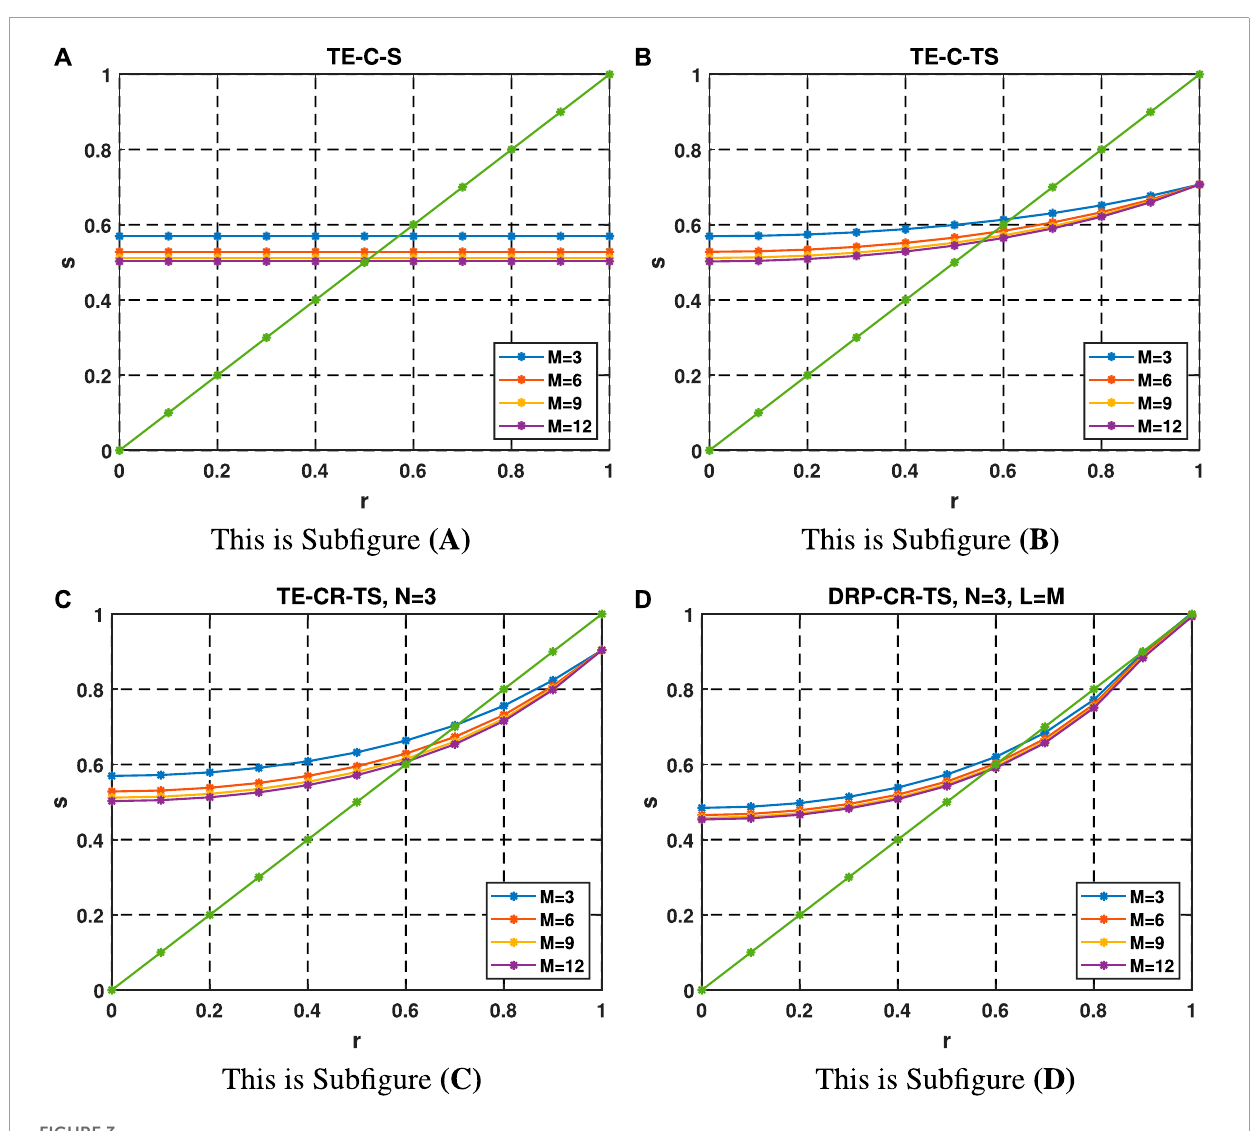
FIGURE 3 Stability factors of the four methods with different r and M , where N = 3 and L = M for the cross-rhombus stencil. The green curve represents s ( r ) = r . (A) TE-C-S method. (B) TE-C-TS method. (C) TE-CR-TS method. (D) DRP-CR-TS